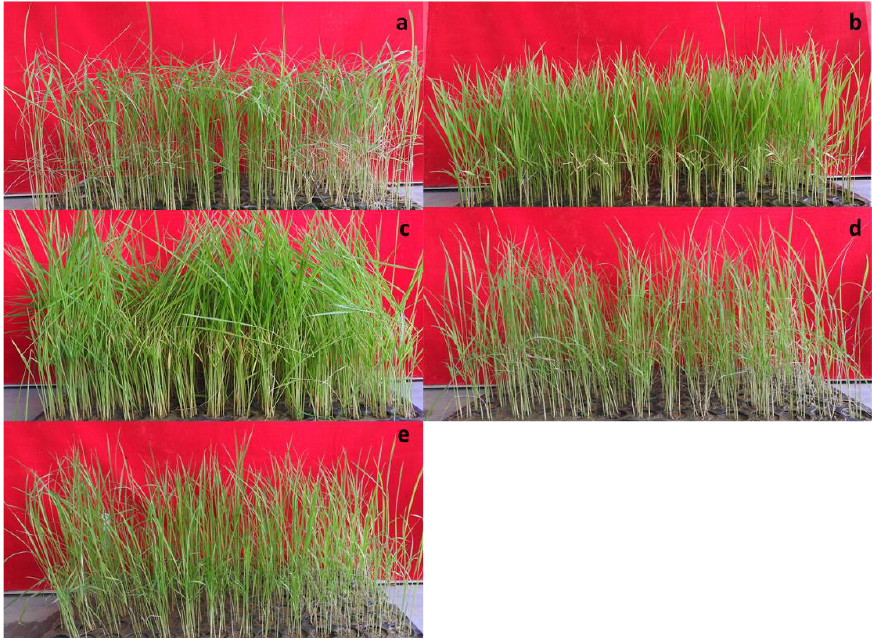
Figure 1. Rice genotypes inoculated with Fusarium fujikuroi isolates and appearance of typical bakanae symptoms . ( a ) PB1509 (susceptible), ( b ) C101A51 (highly resistant), ( c ) IRG52, ( d ) PB1, ( e ) PB6. Table 2. Disease incidence (%) in rice genotypes inoculated with Fusarium fujikuroi